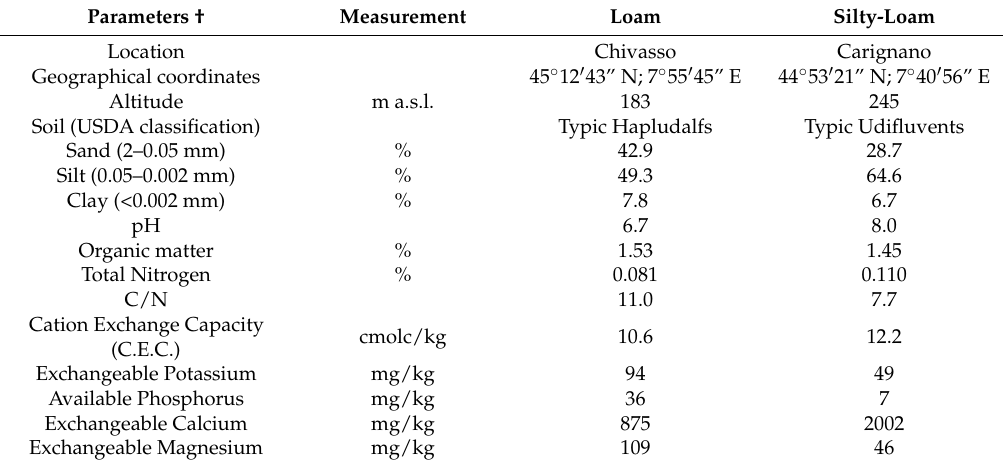
Table 5. The main physical and chemical characteristics of the soils in the field experiments carried out in 2016 in north-western Italy at Chivasso and